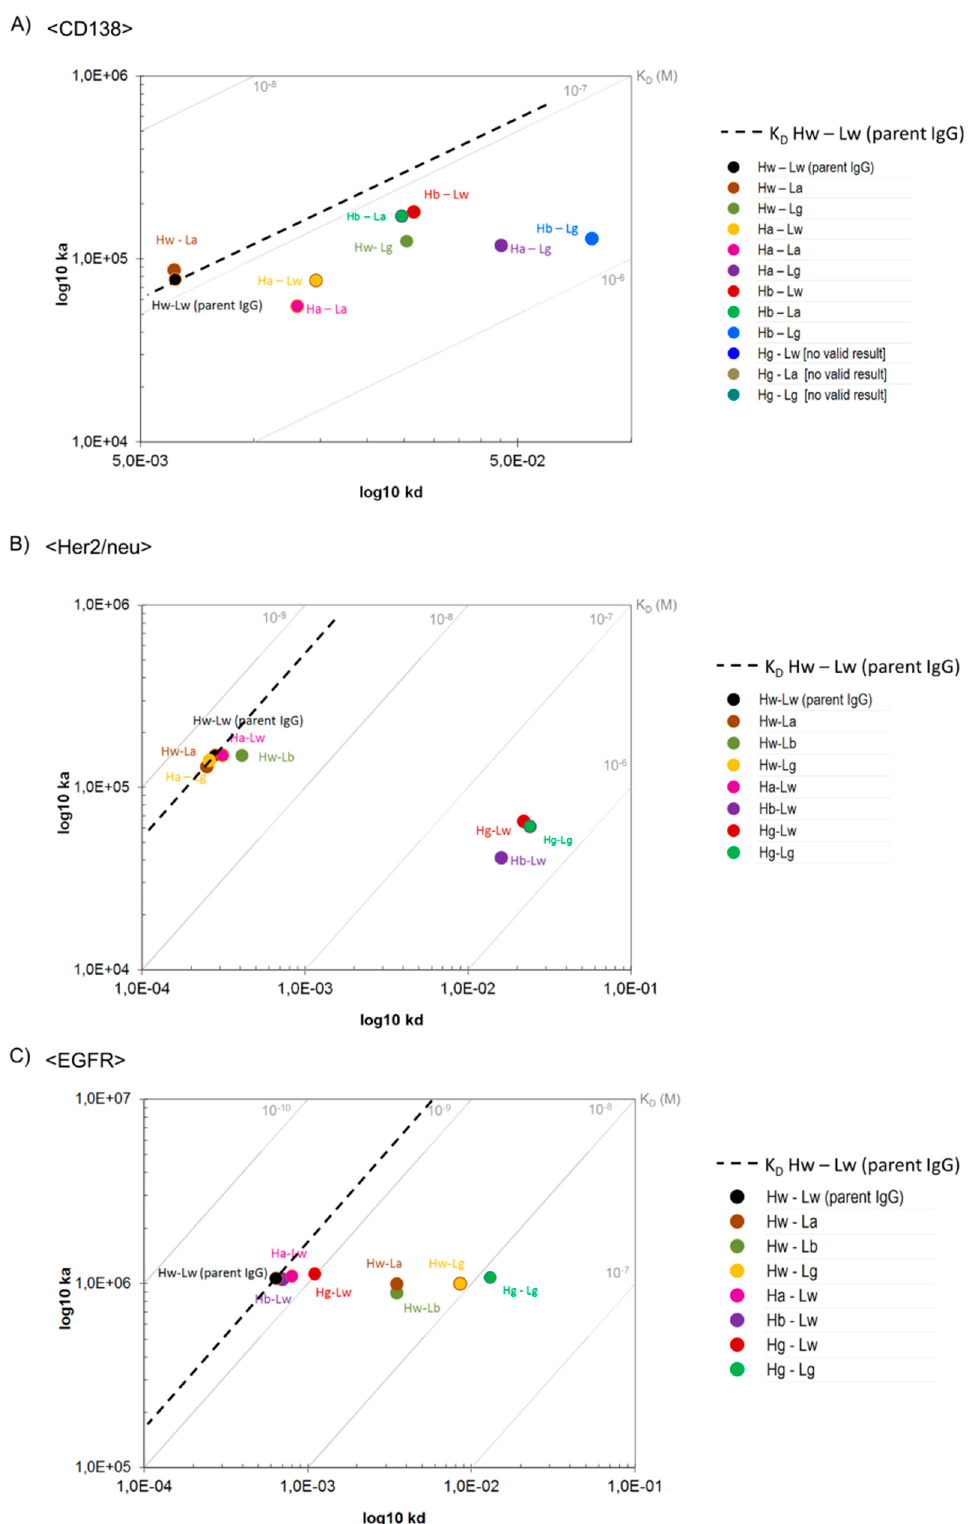
Figure 2. On-/Off-rate plots showing monovalent binding of B2GL variants to antigens. Surface Plasmon Resonance was applied to measure differences in binding kinetics of ( A ) <CD138>, ( B ) <Her2/neu>, and ( C ) <EGFR> variants. As a reference, note the dashed line indicating K D values of parental IgGs.